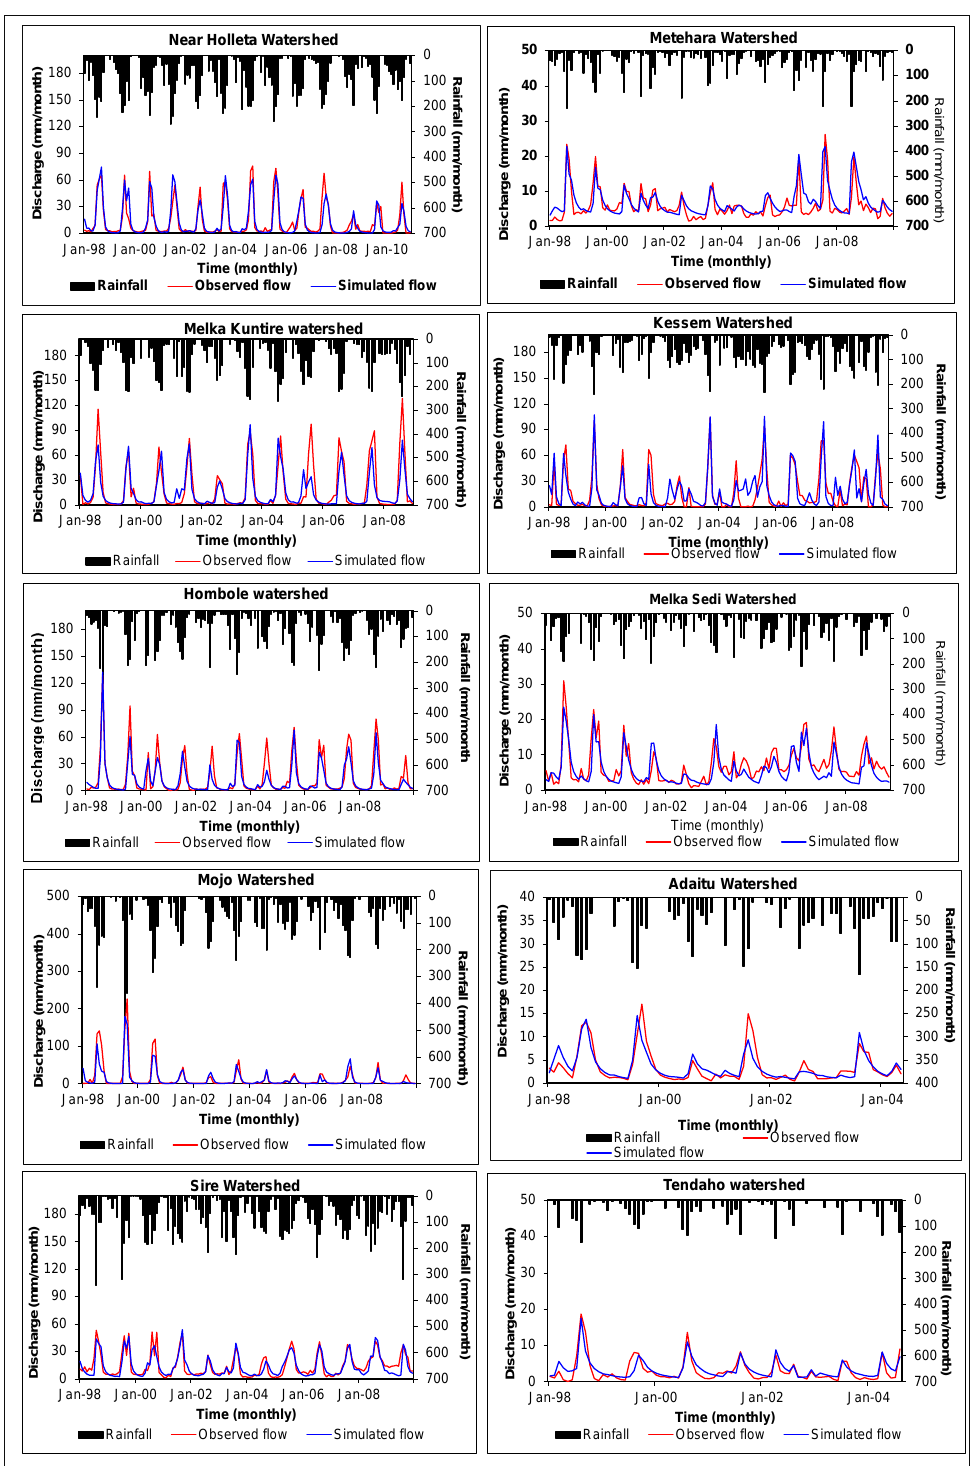
Figure 7. Calibration and validation procedure using gauged observed rainfall and streamflow records of the ARB.